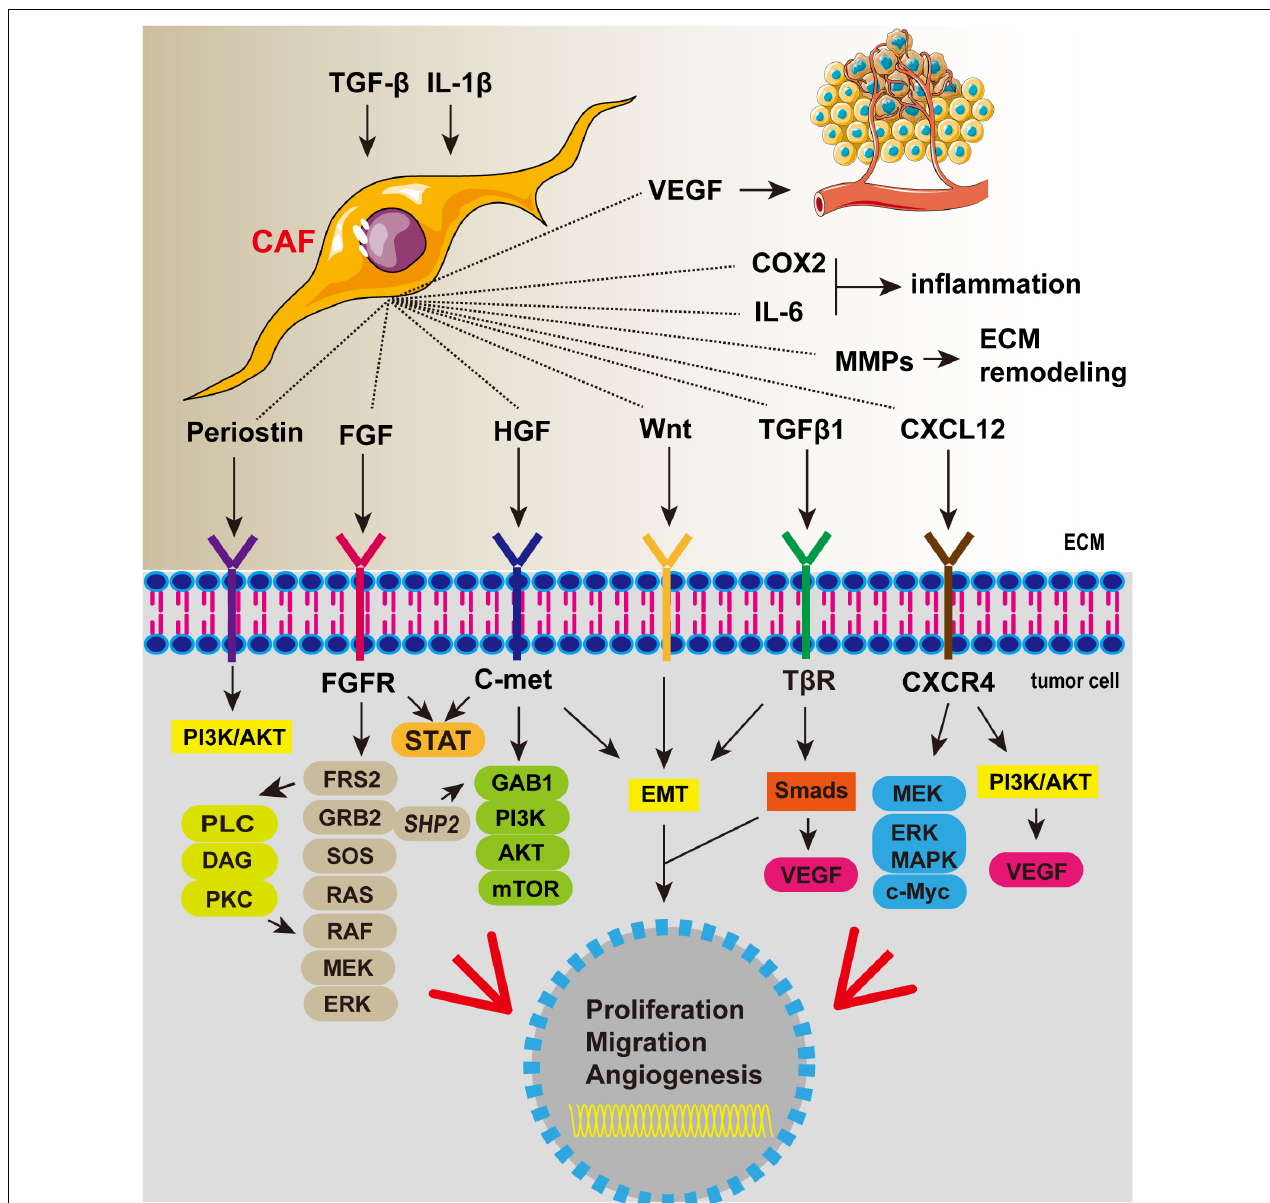
FIGURE 3 | Cancer-associated fibroblasts secrete a variety of cytokines that promote tumor proliferation, invasion, and angiogenesis and aggravate